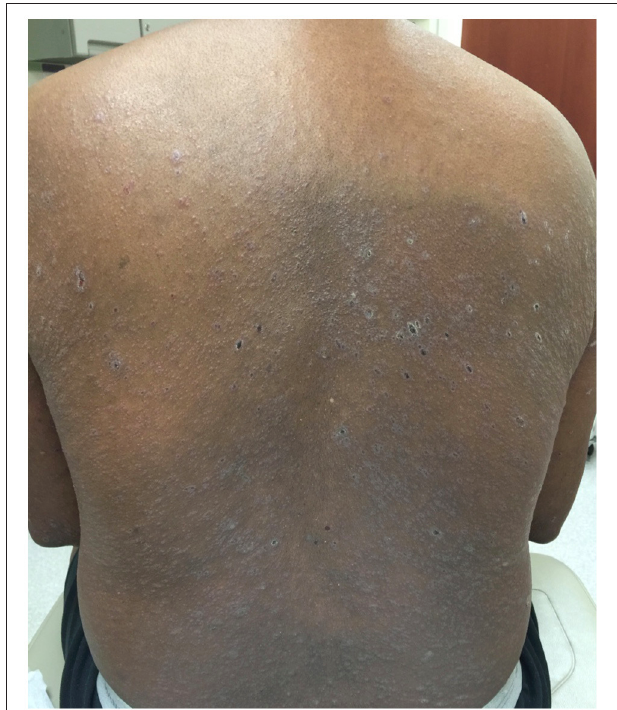
FIGURE 1 | Clinical image of the cutaneous eruption that developed after six cycles of nivolumab. On the back, there were widespread and numerous 3–10mm pink to pink-brown thin flat-topped papules and plaques with scale.